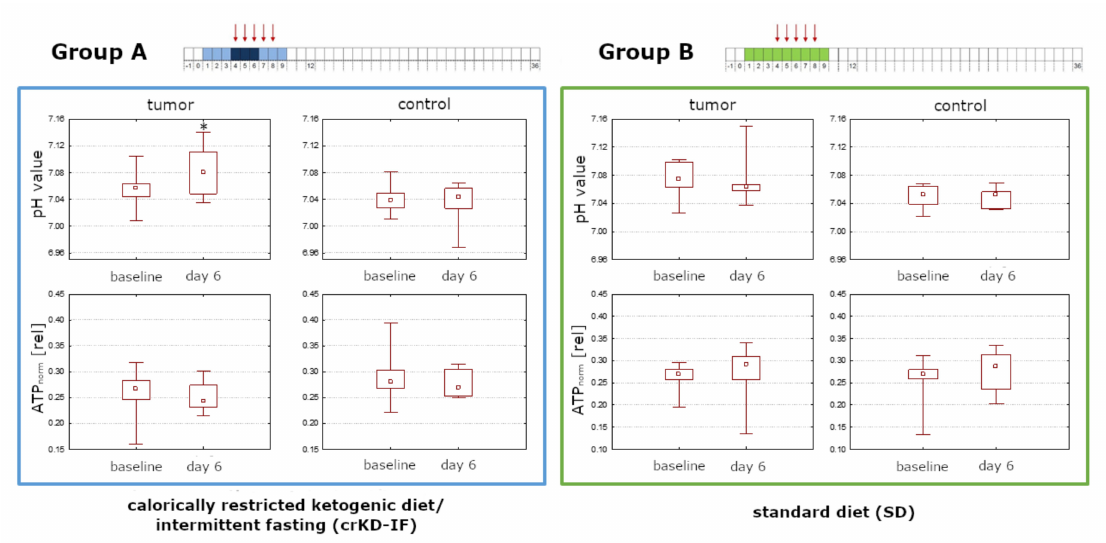
Figure 4. Analysis of the ITT population (11 patients in Group A with crKD-IF and 8 patients in Group B with SD). Group A exhibited a significant increase in pH i in tumor voxels comparing baseline levels to day 6 during crKD-IF ( p = 0.03), while there were no significant changes reported for Group B ( p = 0.48). ATP levels were stable in tumor or control voxels of either group comparing baseline to day 6. A Wilcoxon signed-rank test as a paired, non-parametric statistical hypothesis test was used to compare pH i and ATP levels. Box-and-whisker plots with minimum, maximum, interquartile ranges (25th and 75th percentiles) and median are